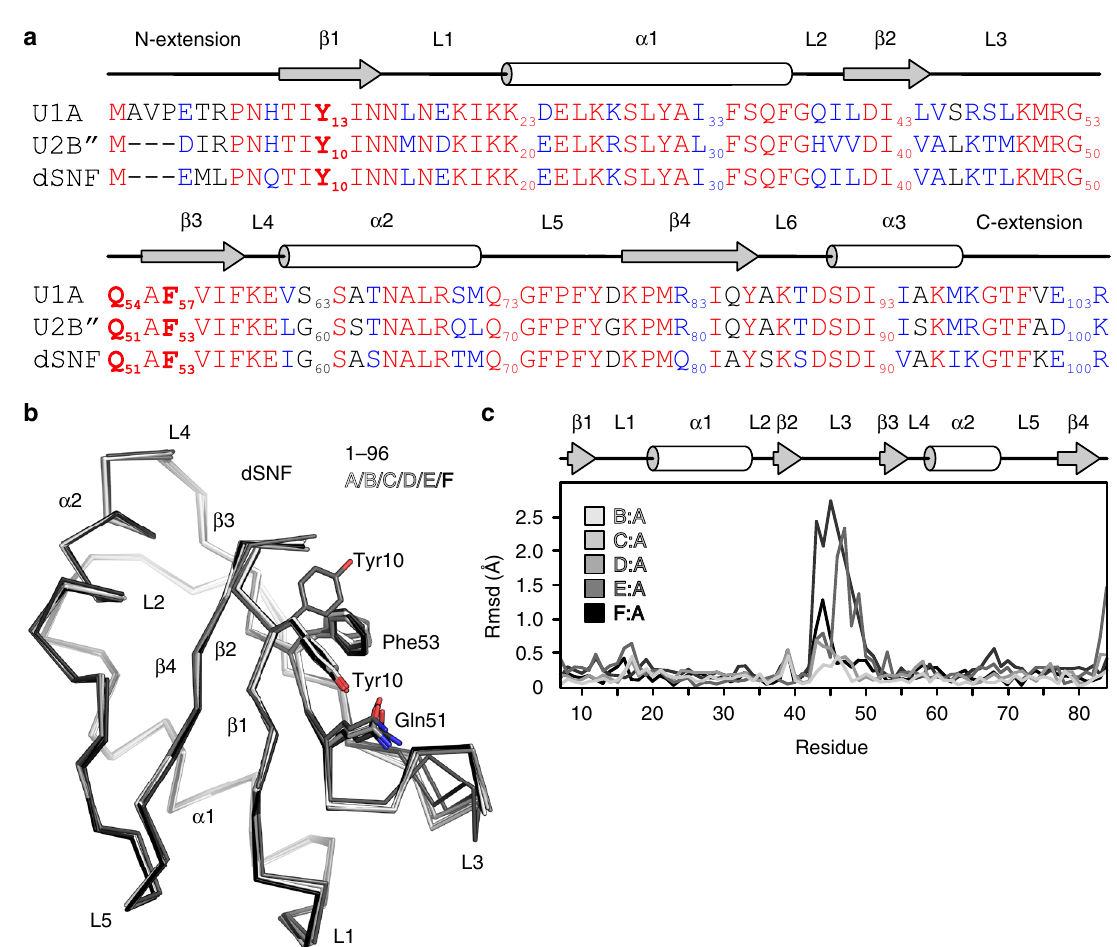
Fig. 1 dSNF 1-96 structure and conformational fl exibility. a Sequence alignment of dSNF RRM1 , hU1A RRM1 and hU2B ″ R RM1 . Identical residues — red; conserved residues — blue. The Tyr10-Gln51-Phe53 triad is highlighted in bold. Secondary structure elements as observed in a dSNF 1 – 96 crystal structure are shown above the alignment (a very short β -sheet within L5 has been omitted for clarity). b Overlay of the six dSNF 1 – 96 molecules (A-F) in an asymmetric unit of a dSNF 1-96 crystal (different shades of gray). Conserved RNA-binding residues (Tyr10-Gln51-Phe53) are shown as sticks. c C α rmsd ’ s of crystallographically independent dSNF 1 – 96 copies relative to molecule A. The N- and C-terminal extensions and the L6 and α 3 regions adopt very different conformations in the different dSNF 1 – 96 copies and have been omitted from the